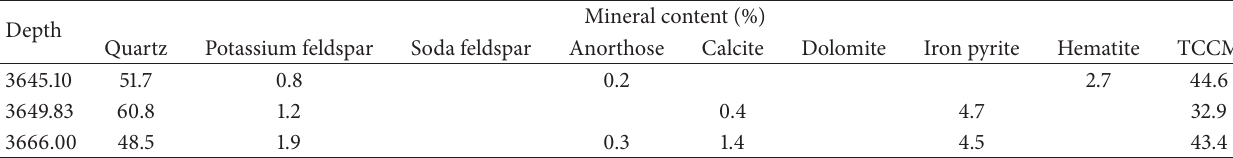
Table 3: Mineral composition and content of the Nahr Umr Shale.